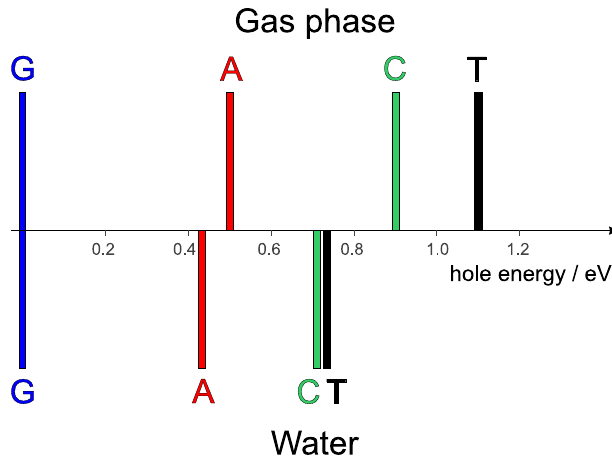
Figure 2. Relative (to guanine) hole energies of DNA nucleobases in the gas phase (top) and in aqueous environment (bottom).